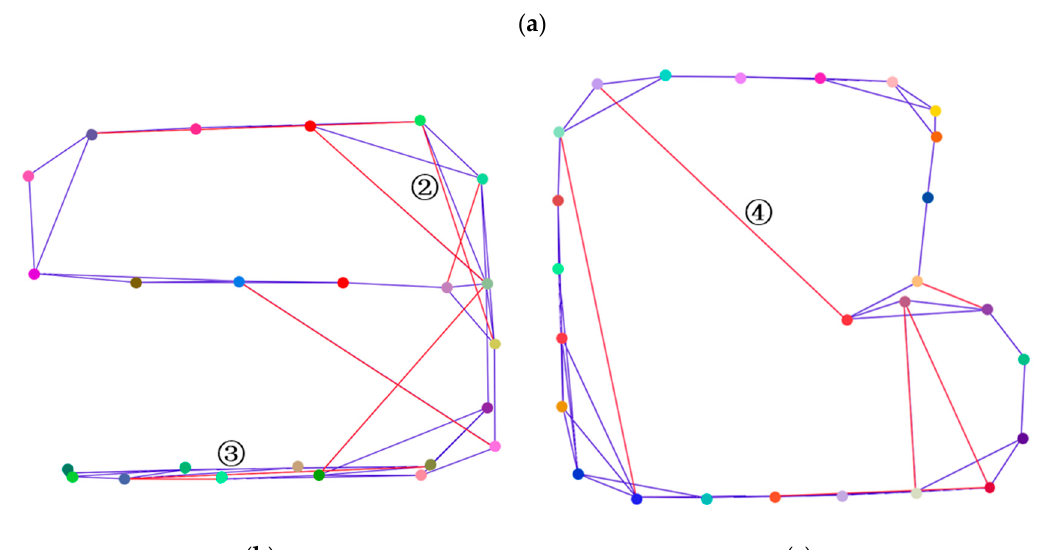
( d ) Figure 17. Examples of registration results corresponding to error edges in the pose graph. ( a ) Registration result corresponds to edge 1 in Figure 16; ( b ) registration result corresponds to edge 2 in Figure 16; ( c ) registration result corresponds to edge 3 in Figure 16; ( d ) registration result corresponds to edge 4 in Figure 16.